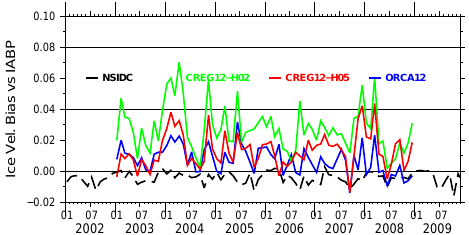
Figure 19. Monthly time series of average bias in monthly ice speed (in ms − 1 ) relative to IABP buoys for NSIDC (black dashed), the ORCA12 T321 run (blue) and CREG12 hindcasts H02 (green) and H05